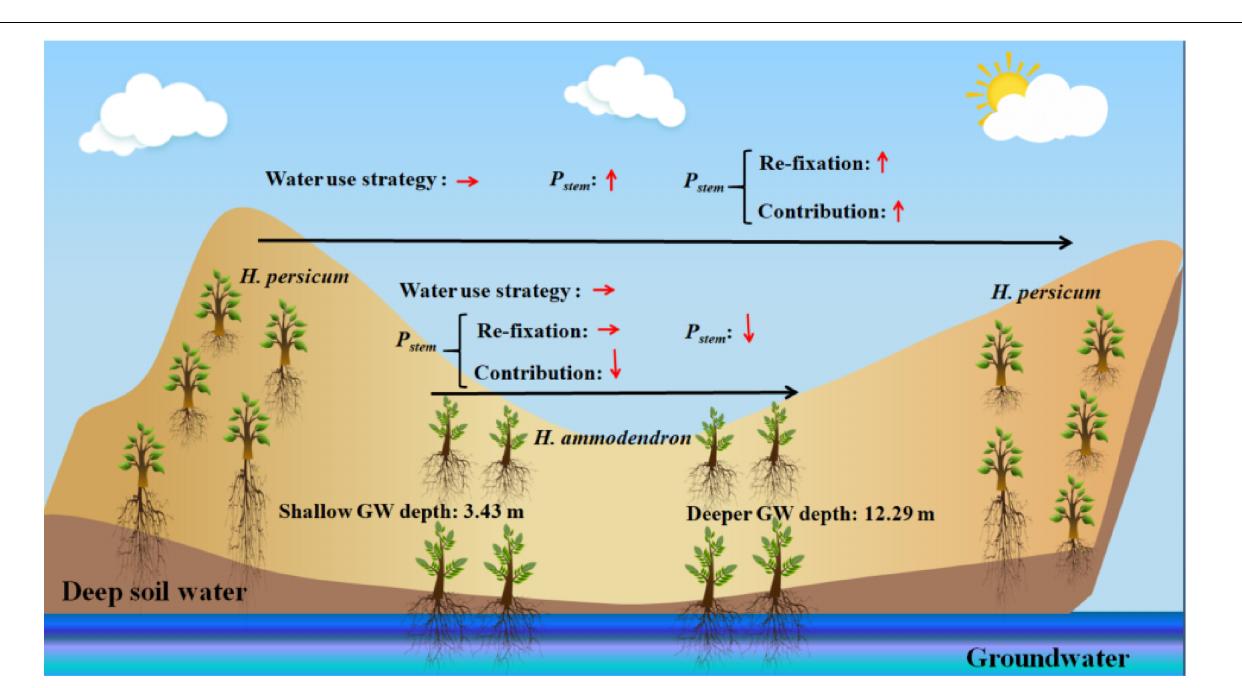
FIGURE 8 | Conceptual diagram illustrating the main results of this study. GW,